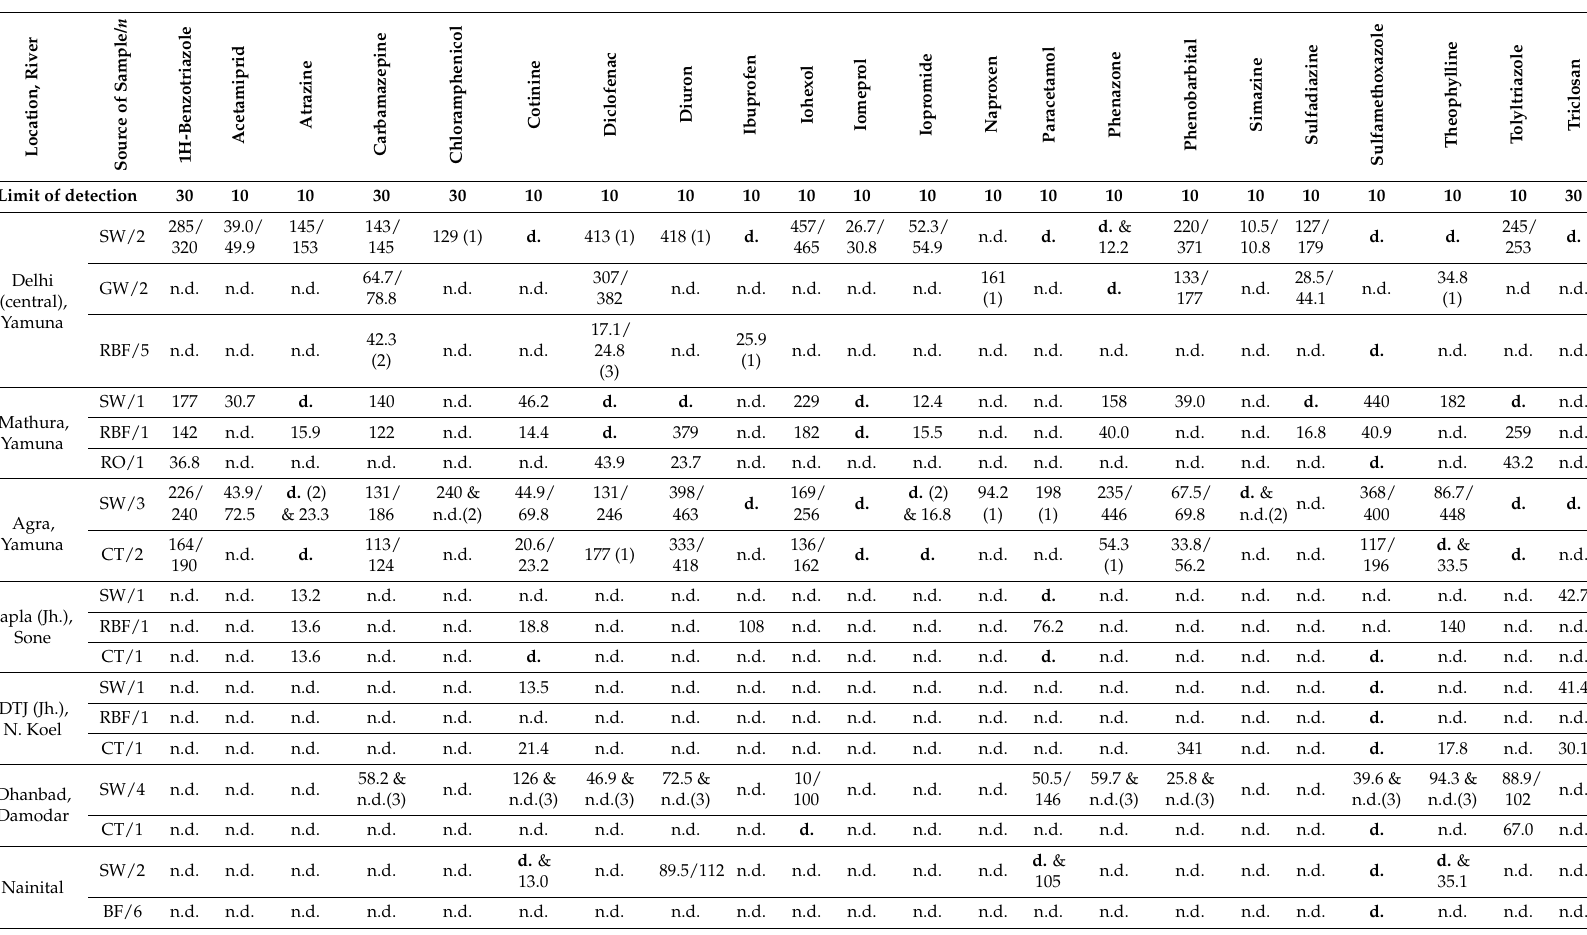
Table 3. Concentrations of OMPs at selected sites where their presence was detected in non-monsoon 2014, given as median and maximum (separated by /) values in ng/L. Values in parentheses () indicate the number of samples these values are based on (if (cid:54) = n in column 2), or the number of samples wherein the OMP was not detected